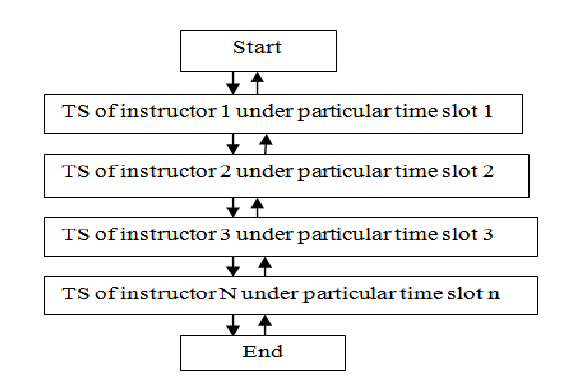
Figure 1. Route Formation for Teaching